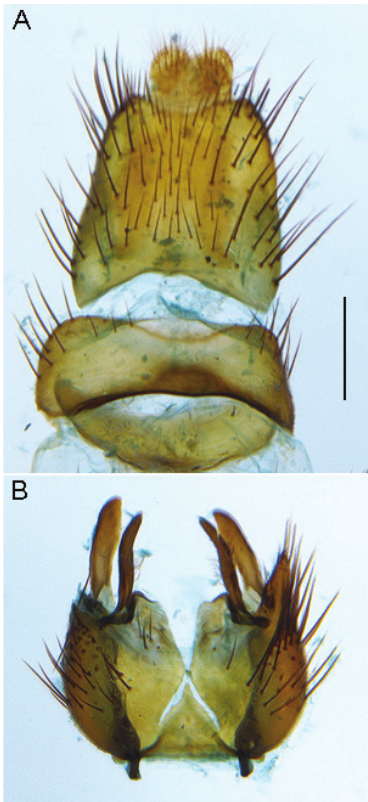
Figure 9. Sidarena flavipalpa sp. n.: A Epandrium and tergite 8, dorsal view B Gonocoxites, ventral view (epandrium and aedeagus removed). Scale line: 0.2